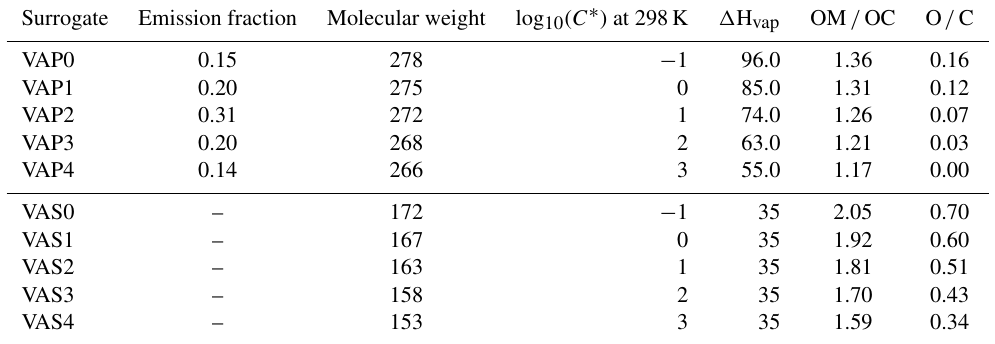
Table C1. Properties of the VBS species (the primary and secondary anthropogenic SVOCs). The molecular weights are in gmol − 1 . (cid:49) H vap is the enthalpy of vaporization in KJmol − 1 , which describes the temperature dependance of the saturation pressure C ∗ . Surrogate Emission